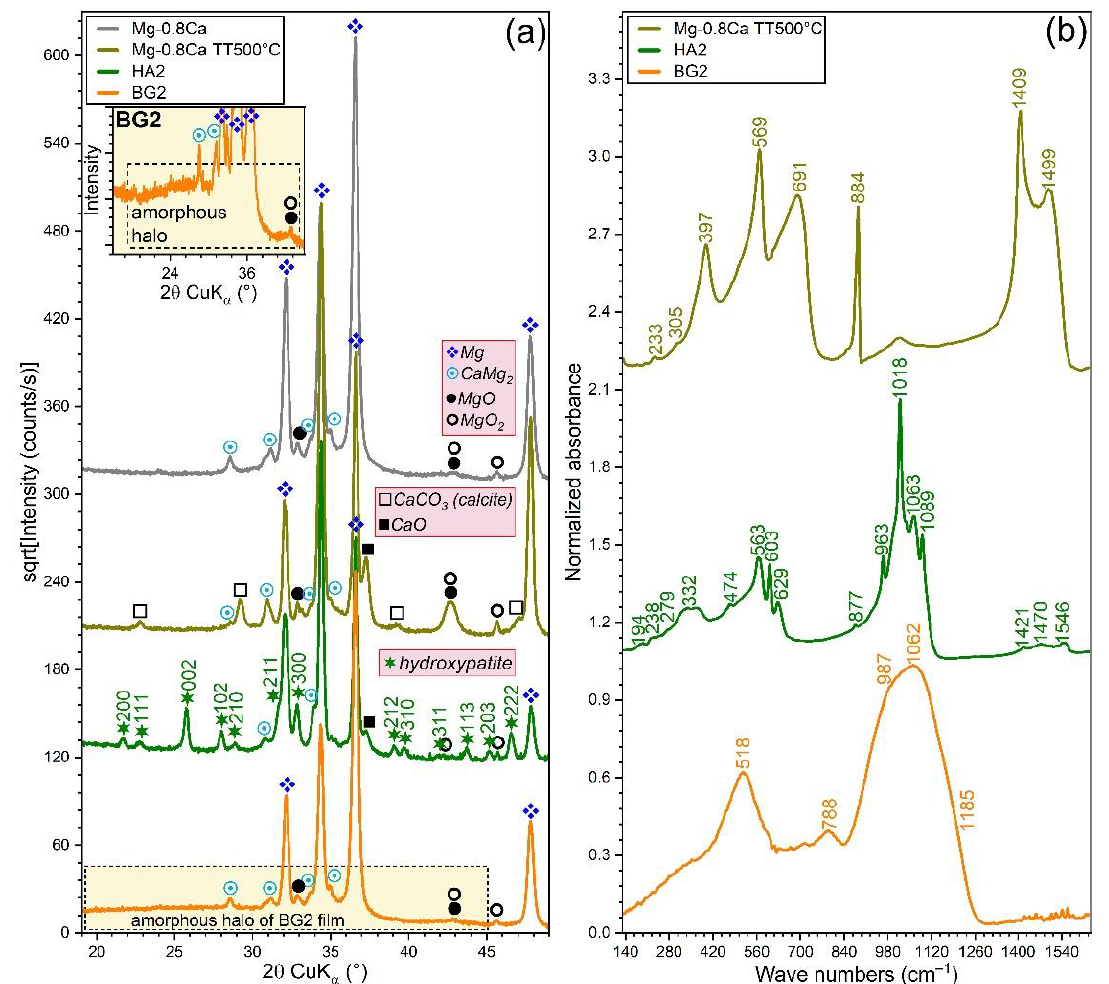
Figure 4. ( a ) XRD patterns (recorded in grazing incidence mode, α = 2°) and ( b ) FTIR-ATR spectra of the bare as-fabricated and 500 °C-annealed Mg-0.8Ca substrates and of the HA2- (post-deposition heat-treated at 500 °C/1 h in air) and BG2- (as-sputtered) RF-MS functionalized Mg-0.8Ca substrates. Inset in ( a ): Zoomed region (rescaled on the intensity Y -axis) allowing to visualize the amorphous hump, specific to the BG2-type film.